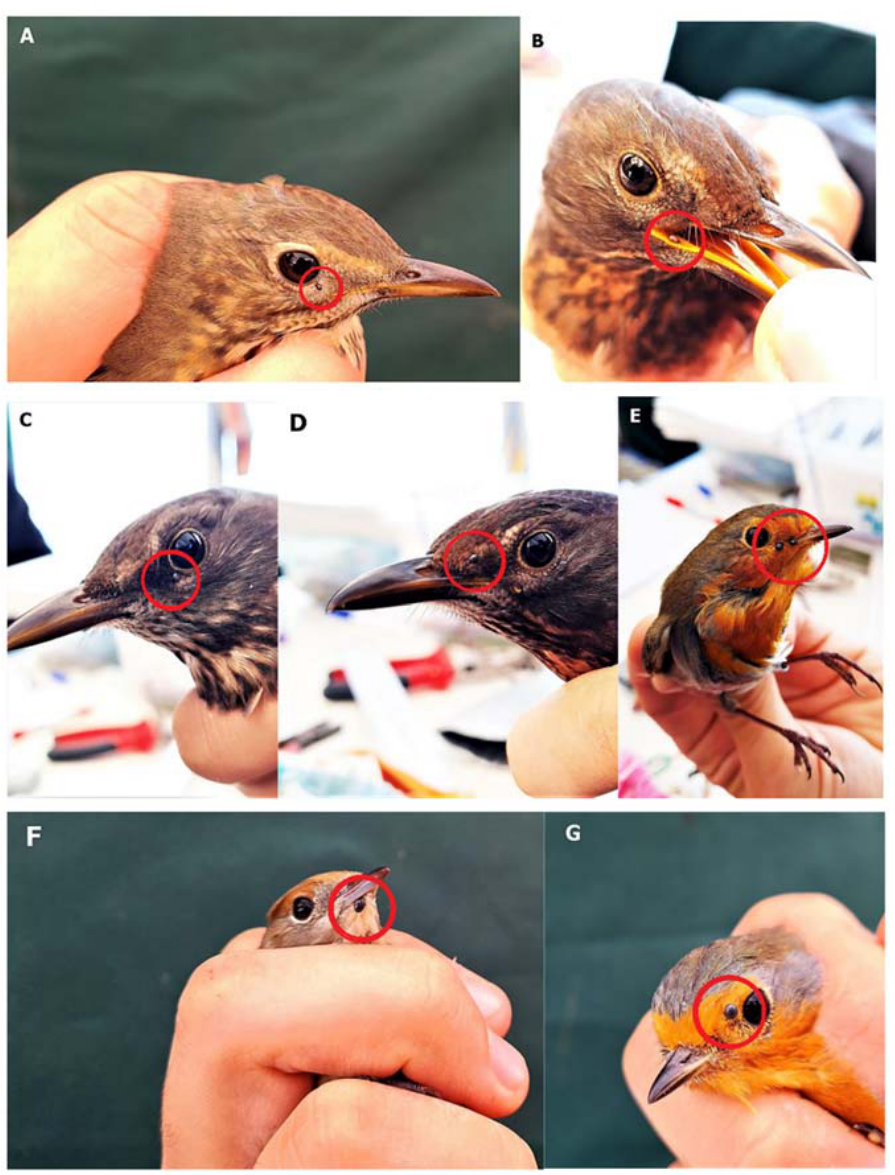
Figure 2. Ixodes ricinus ticks infesting birds. ( A ) Turdus philomelos , larva attached to the eyelid; ( B ) T. merula , nymph in the gape; ( C ) T. merula , nymph feeding near the eyelid; ( D ) T. merula , nymph feeding on the lore; ( E ) Erithacus rubecula , nymphs feeding on the lore; ( F ) Sylvia atricapilla , nymph attached to the chin; ( G ) E. rubecula ; nymph feeding on the lore. Photo by Z. Zaj ą c. Seven species of Ixodes were identified among the 335 ticks collected from the